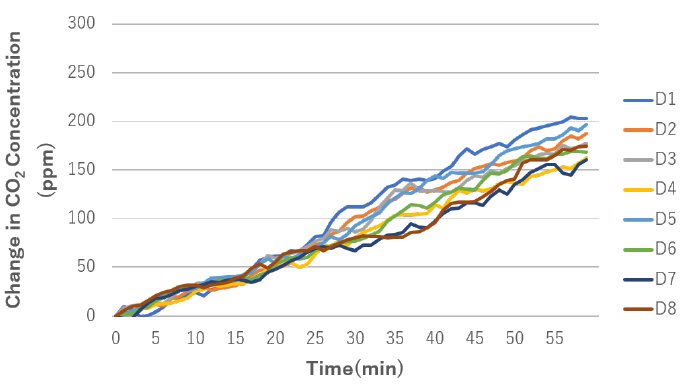
Figure 6. CO 2 concentration change in Case1. DX means Device ID.